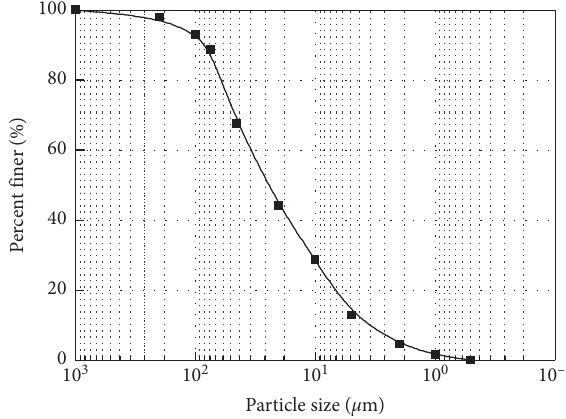
Figure 1: Particles gradation curve of loess